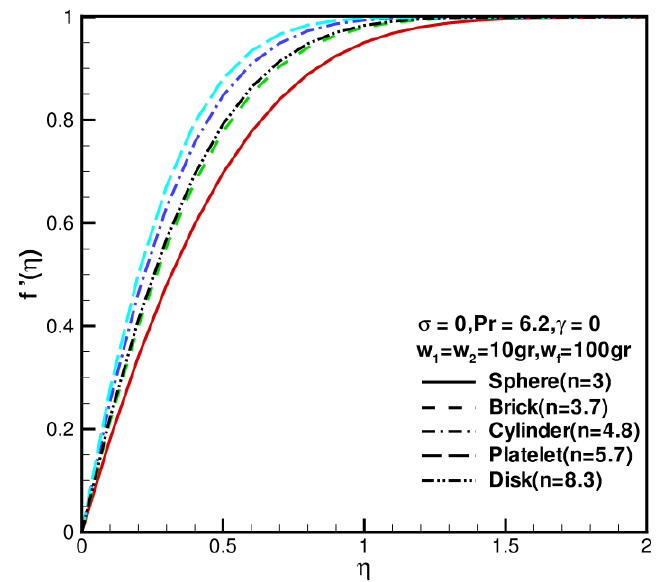
Figure 2. The dimensionless velocity component f (cid:48) ( η ) against the shape factor n when w 1 = w 2 = 10 gr, w f = 100 gr, σ = 0, Pr = 6.2, and γ = 0.